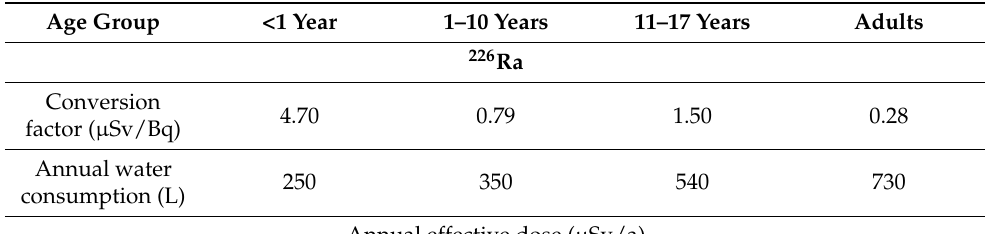
Table 3. Average annual effective doses of 226 Ra uptake in drinking water in the tested mineral water